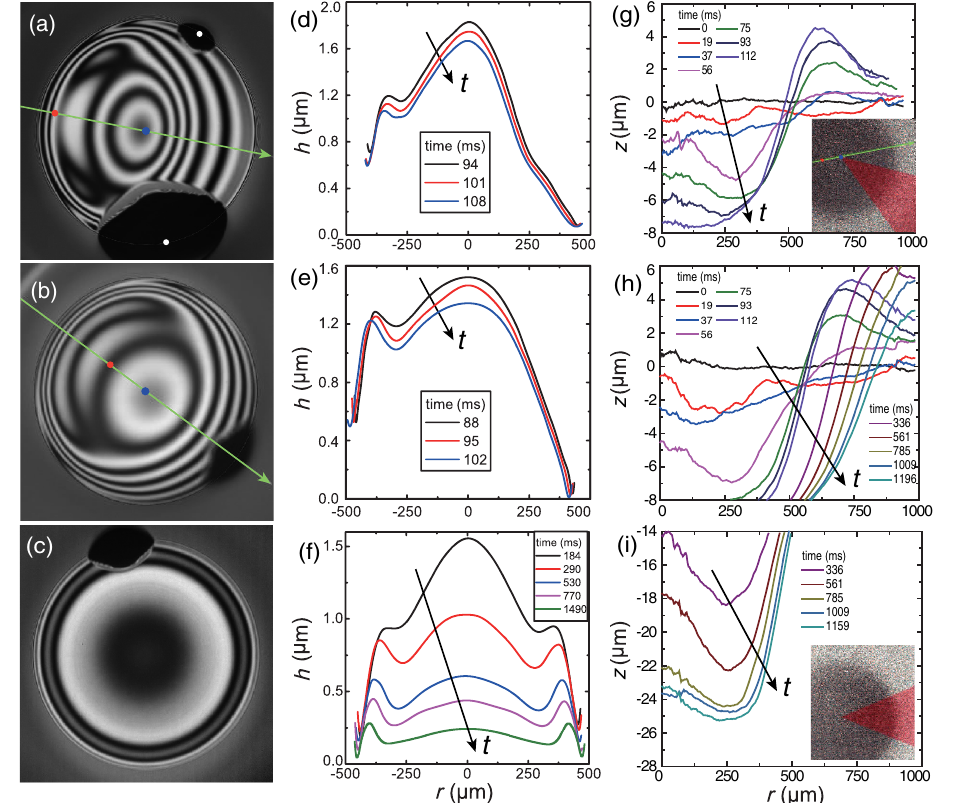
FIG. 2. Underlying mechanism for short and long lifetimes. (a) – (c) Initial contact at large, small, and zero tilt angles. Panels (a) and (b) have short lifetimes and (c) has a long lifetime. In (a) and (b) the droplet center moves from the red to the blue spot along the green arrow line, which is also the axis of symmetry. For large θ in (a), two contacts locate symmetrically beside the green line, but they converge into one as θ decreases in (b). For the leveled situation in (c), a single contact occurs randomly on the perimeter. (d) – (f) Air gap profiles corresponding to (a) – (c). They are measured along the green arrow line for (a) and (b), and along an arbitrary diameter for (c). They decrease with time and the lowest curve is right before the contact moment. Apparently, (d) and (e) have asymmetric profiles whose narrow region at the front produces early contact and a short lifetime, while the symmetric air gap in (f) leads to the long lifetime. (g) – (i) Liquid film deformation below the drop. Panel (g) illustrates a typical short-lifetime experiment: the surface sinks at the center with the magnitude 8 μ m but rises around the edge. Panels (h) and (i) show the long-lifetime situation. Because of limited dynamic range, they come from two identical experiments with focal planes 20 μ m apart. The surface sinks much deeper to 25 μ m, which prevents the droplet from skidding and causes long lifetime. Insets are snapshots by confocal microscopy, and averaging the red region yields one typical curve in the main